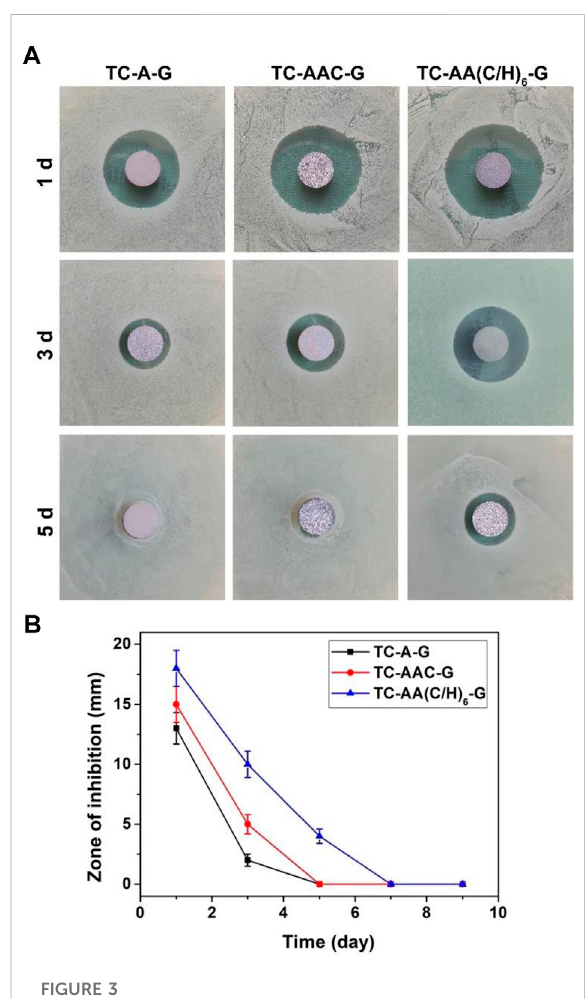
FIGURE 3 Thezoneofinhibition(ZOI)ofmultilayermembranemodi fi ed TCs loading gentamycin. (A) The ZOI against S. aureus produced by different specimens at different time points; (B) The ZOI diameters of all